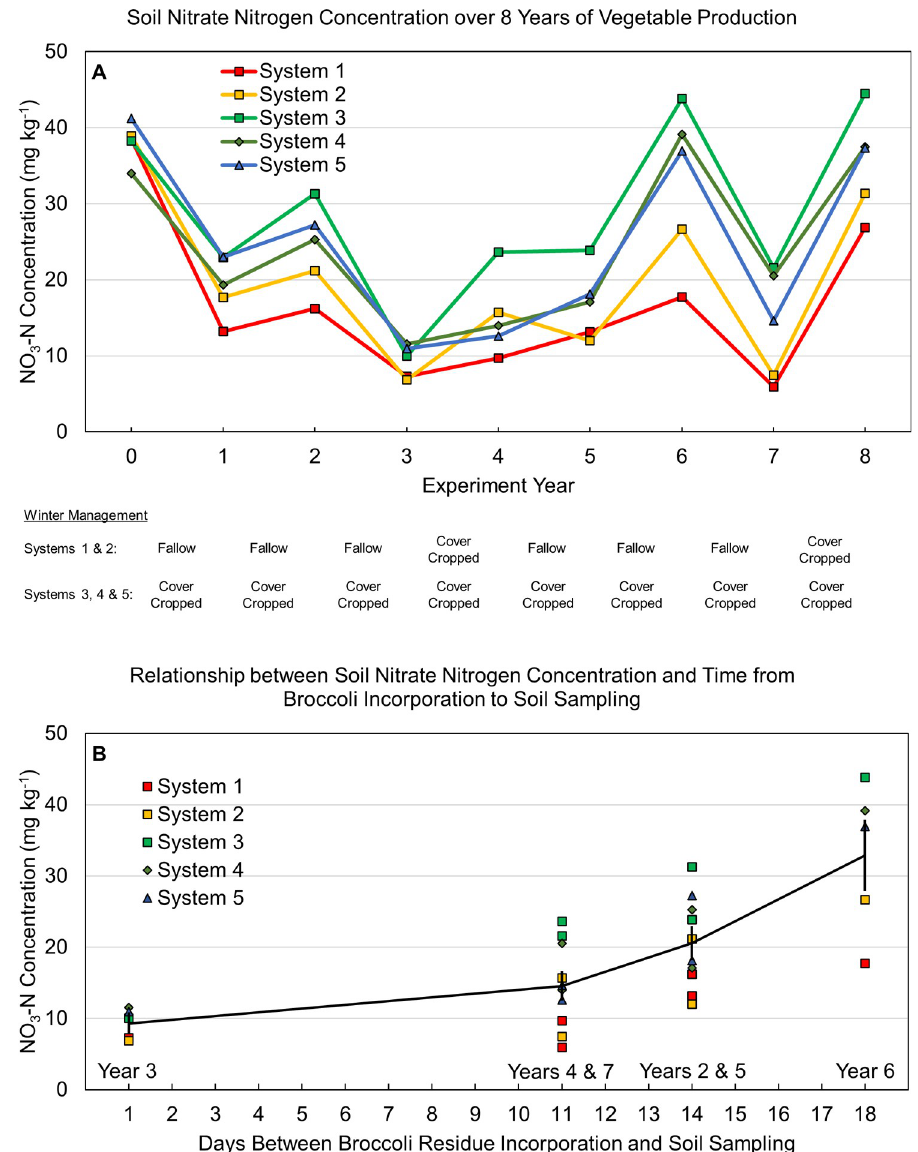
Fig 3. Post-harvest soil nitrate nitrogen concentration over 8 years of vegetable production. Samples were taken after incorporating the last vegetable crop each year and before cover cropping or fallow. Systems differed by annual compost additions, cover crop type and cover cropping frequency. Samples were taken at the 0 to 30 cm depth after the 2 nd vegetable crop before winter fallow or cover cropping for years 1 to 7 when two vegetable crops were grown annually (A). When broccoli was grown after lettuce (Years 2 to 7), the relationship between nitrate nitrogen concentrations and days after broccoli incorporation is shown (B); the individual data points represent the mean value for each system and the year(s) that the data correspond to is shown above the x axis. The error bars in plot B are 95% confidence intervals for the mean values.